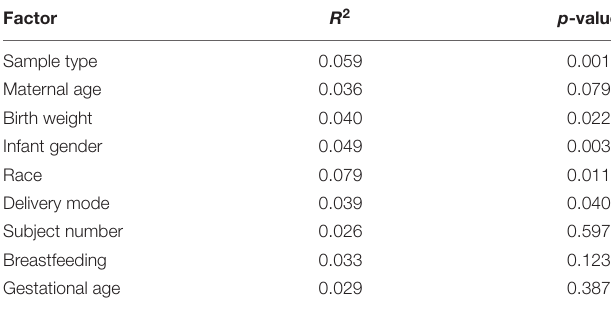
TABLE 3 | Contribution of the different factors to the diversity of the microbiome in stool and MOM samples.